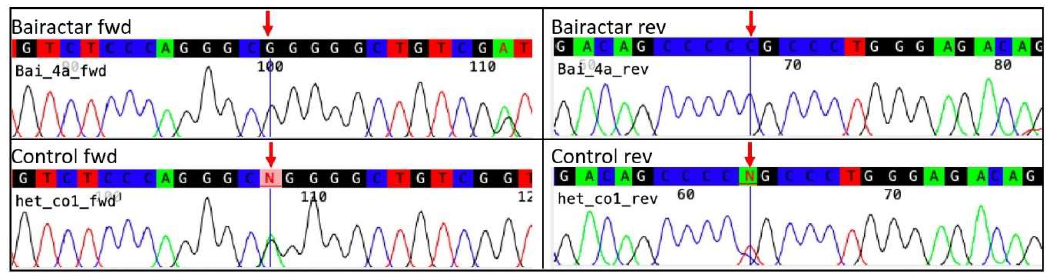
Figure 2. Sanger sequencing traces of Bairactar Or. Ar. ( upper panels ) and one heterozygous control horse ( lower panels ). The electropherograms correspond to sequences obtained with forward ( left side ) and reverse ( right side ) primers. The position of the WFFS single nucleotide variant (SNV) (procollagen-lysine-2-oxoglutarate-5-dioxygenase 1 gene (PLOD1) c.2032G>A) is marked with a red arrow.